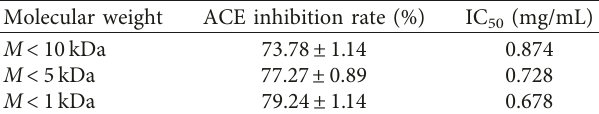
50 of the ultrafiltration frac-